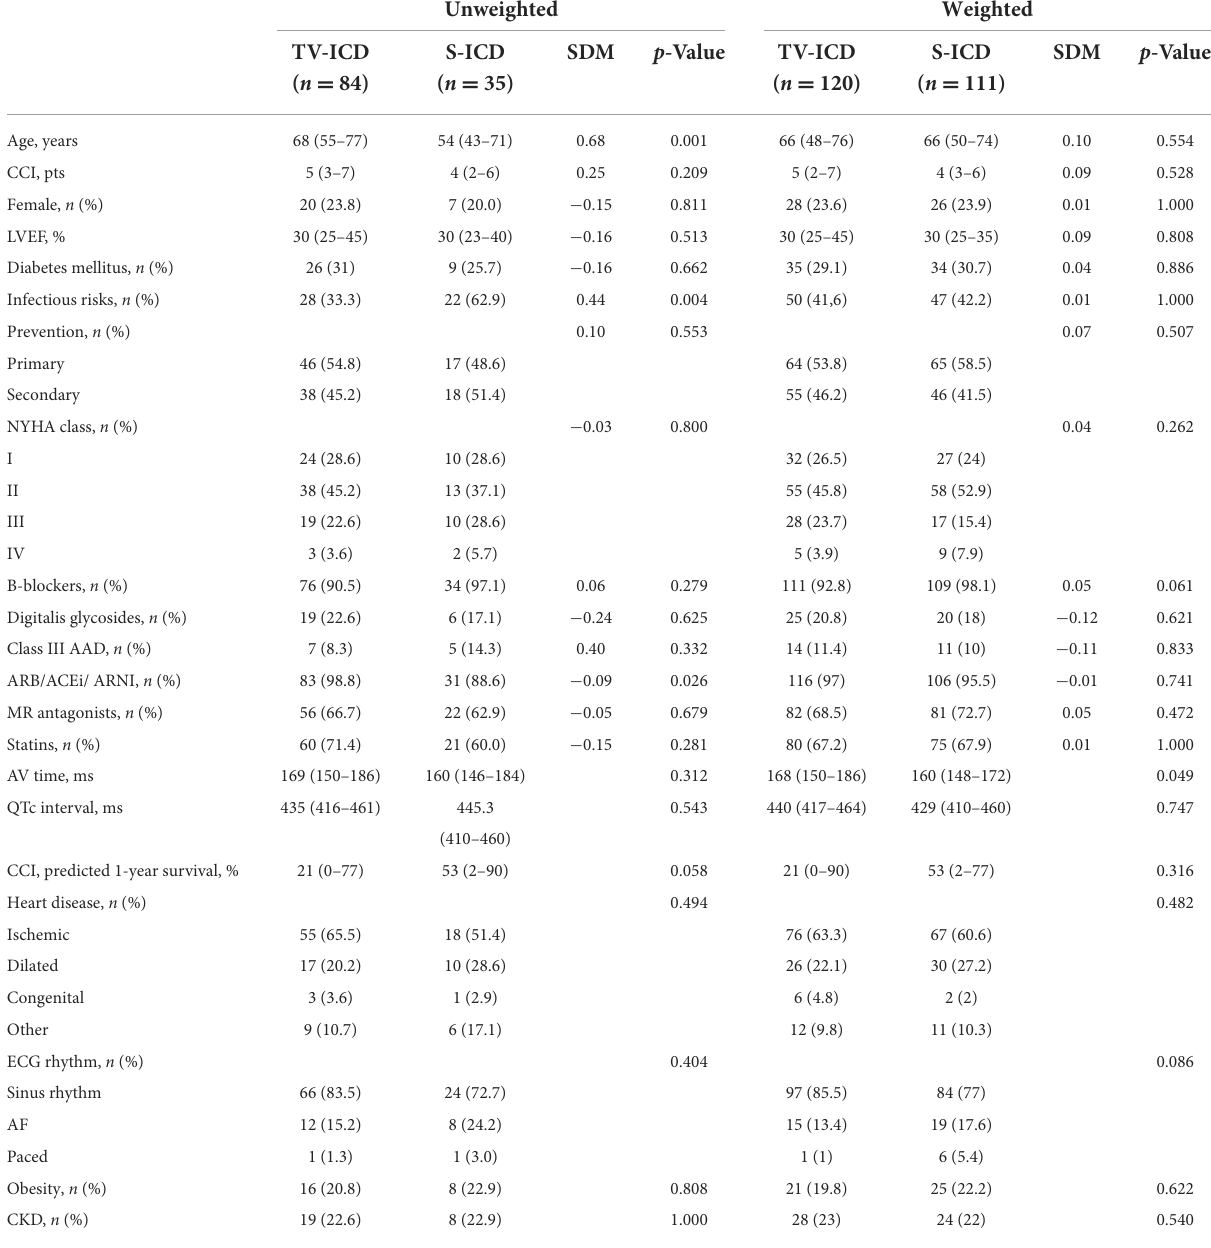
TABLE 1 Baseline characteristics of the unweighted and weighted study